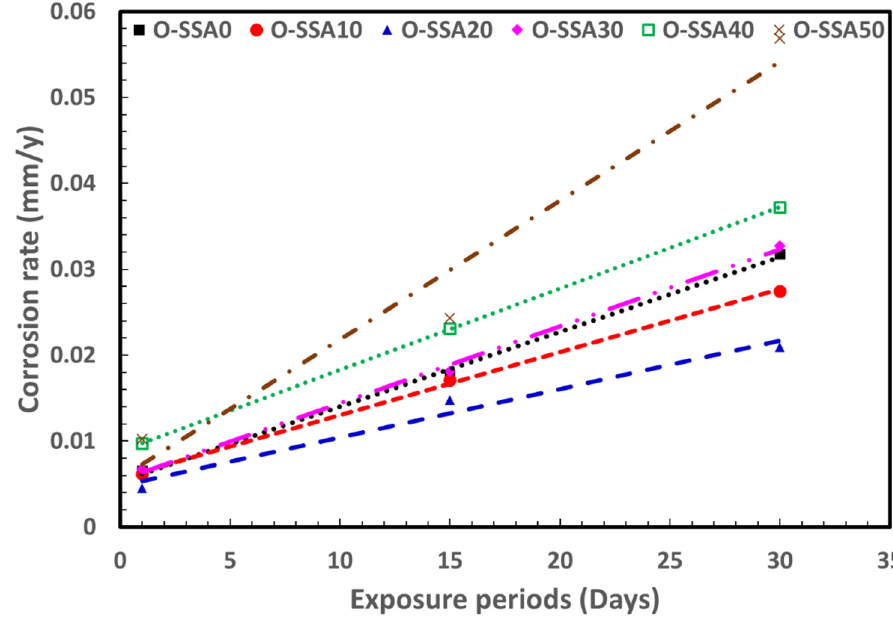
Figure 15. Corrosion rate vs. exposure periods .